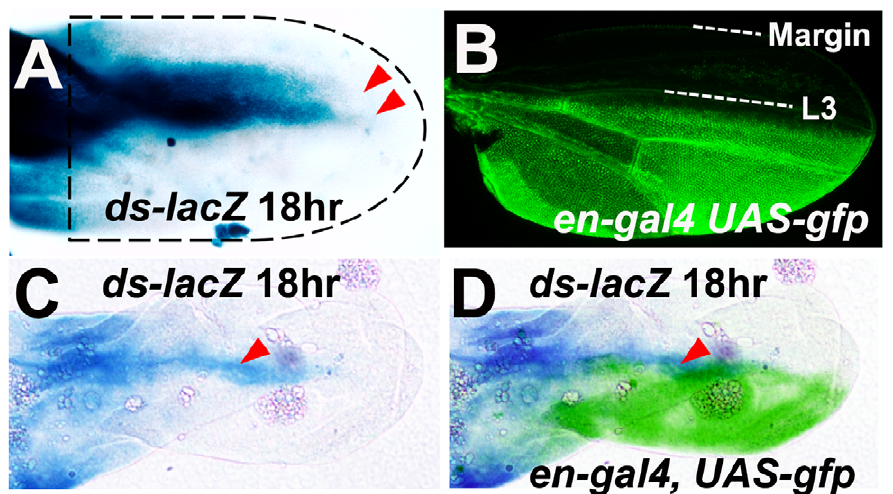
Figure 6. Symmetric ds expression gradients are centered on the L3 vein at 18 hours a.p.f. (A) An 18 hour ds-lacZ pupal wing stained for beta-galactosidase activity (blue). The dashed black line represents the approximate outline of the wing. Red arrows define the distal limit of beta- galactosidase activity on the dorsal and ventral epithelia. (B) Wing from a newly eclosed en-gal4 , UAS-gfp fly showing GFP fluorescence (green) in the posterior wing. (C) An 18 hour ds-lacZ / en-gal4 , UAS-gfp pupal wing stained for beta-galactosidase activity (blue). Note that this wing has been stained for a shorter period than the wing in (A) in order to identify just the highest levels of enzyme activity (indicated by red arrowhead). (D) Same image as (C) overlaid with a color-inverted and falsely colored (green) image of GFP staining in the same